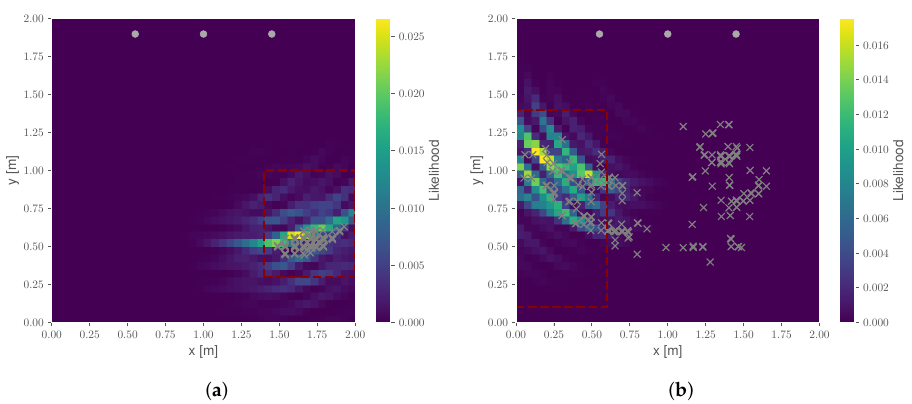
Figure 12. Grid-based mapping and detection: ( a ) mapping with Table 3 in use (dataset I) and ( b ) mapping with seat 1 occupied (dataset IV). Estimated positions for all observation steps (grey crosses), sensor position (grey dots) and detection area (red). In addition, the probability map is displayed, including the Likelihood result of the last observation step. Table 2. Detection rates of the mapping approach for different use cases and environments.